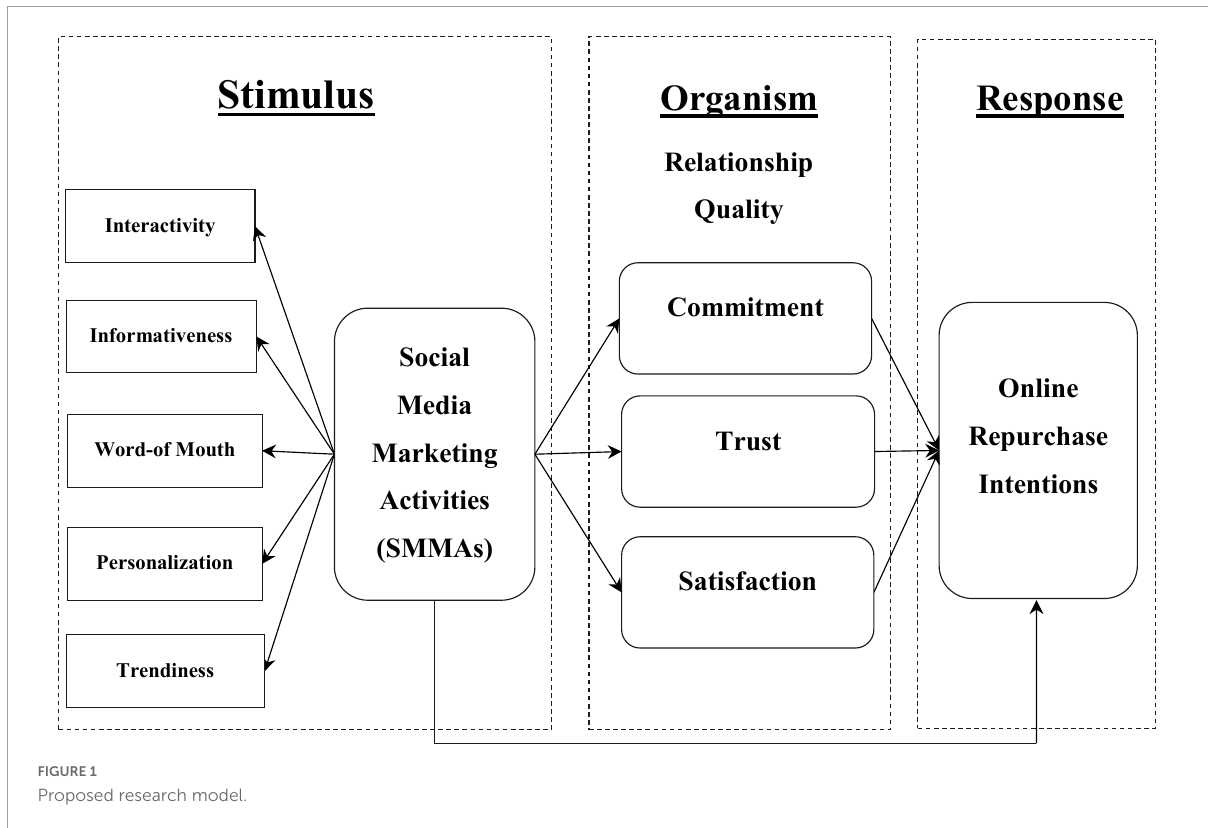
intentions (as consumer response) in the context of China’s e-commerce